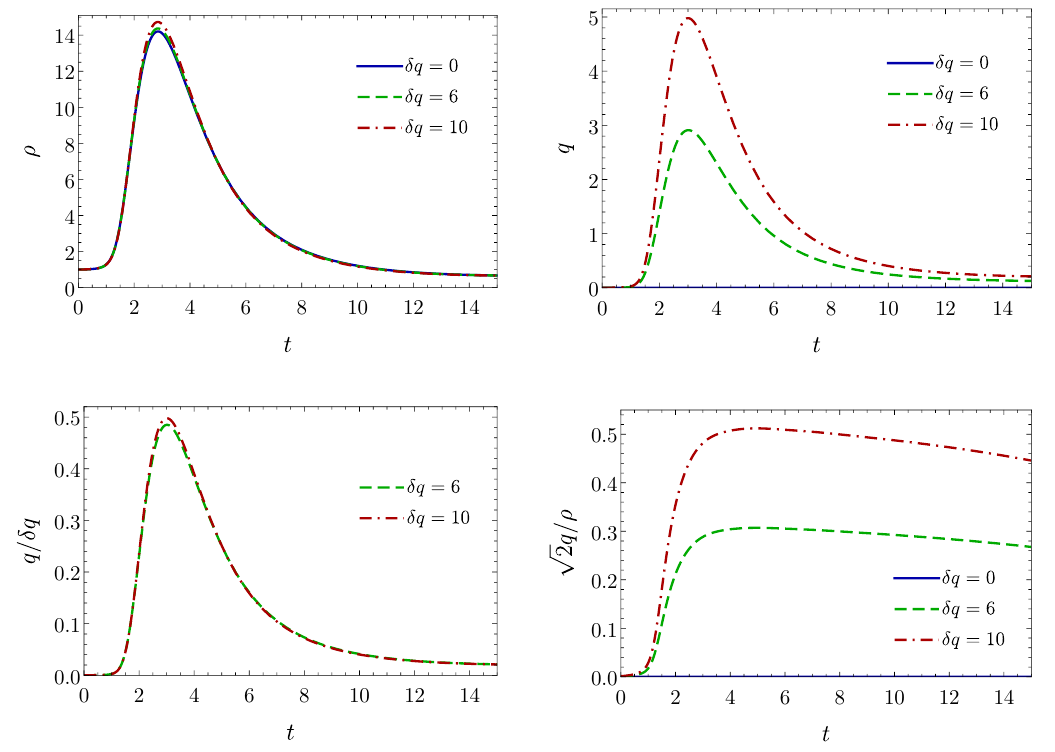
√ 2 q/ρ at the spatial